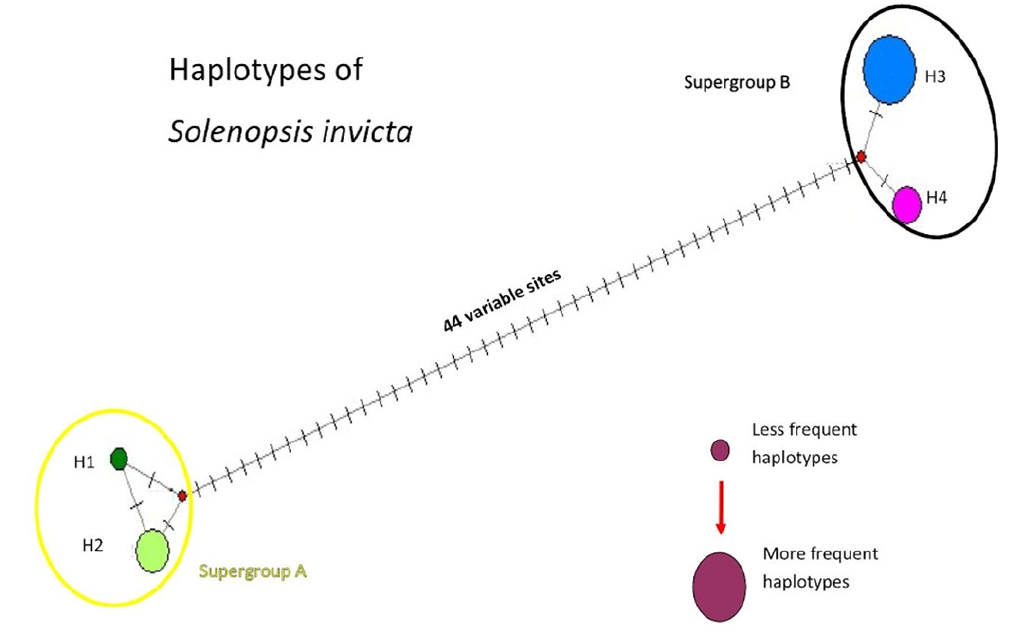
Figure 3. Haplotypes network of Red Imported Fire Ants Solenopsis invicta sampled from the north and south faces of the Serra do Mar Mountain range in São Paulo, Brazil. Supergroup A haplotypes were restricted to the south face of the mountains, and supergroup B haplotypes to the northern face. The haplotype circle size represents the frequency observed, and the whiskers dividing distance lines indicate the numbers of nucleotide differences between haplotypes. Red dots were added by the software, suggesting a hypothetical haplotype. 4. Discussion In this study, we characterized the molecular diversity of S. invicta populations bordering the Atlantic Forest near the seacoast of São Paulo State in Brazil. The study area was selected to contain a significant geographical formation including two well-defined faces of a forested mountain range, which—in principle—cannot be colonized by fire ants. In short, the obtained results indicate a pattern in which imported mitochondrial haplotypes H1 and H2 (supergroup A) colonized the south slope facing the seaside, not far from a maritime port at the city of São Sebastião (São Paulo State, Brazil), while native haplotypes H3 and H4 (supergroup B) were restricted to the north slope facing the continental plateau, likely coming from western Brazil. The fact that H1 and H2 remain limited to the south slope is both indicative of a recent introduction and of the effect of the Serra do Mar range as a geographical barrier delaying the invasive population from expanding into the continent. We further elaborate on this hypothetical scenario below. The Red Imported Fire Ant is believed to have originated from the western border of Brazil with adjacent countries, spanning grasslands and wetlands in Paraguay, Bolivia, Argentina, and Uruguay [32,52]. The species was first recorded in the state of São Paulo in the late 1980s in the Cerrado biome [53], likely already resulting from an expansion beyond its original natural range. Habitat suitability in disturbed lands, local suppression of specialized predators, and their typical aggressive competitive behavior may have driven a local expansion into regions adjacent to their original territory of natural occurrence [12,20]. Also, their generalist diet habits allow this fire ant species to take advantage of a broad variety of food items [54] while adapting to new foraging ground. As RIFAs display a marked preference for open disturbed environments [55], the